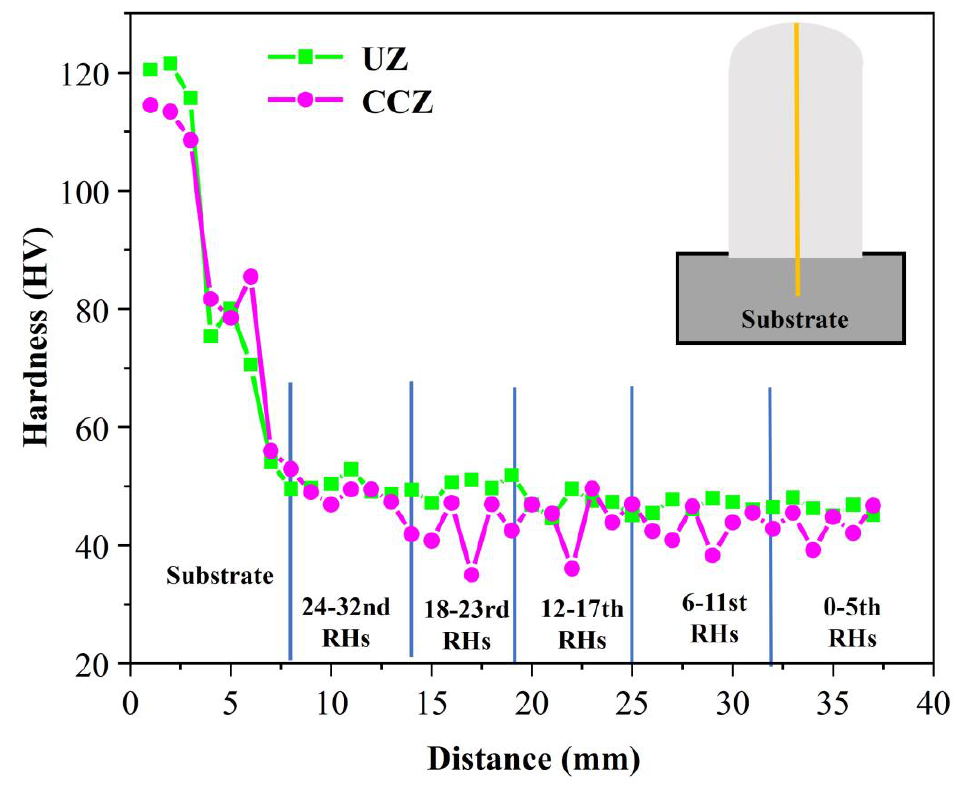
Figure 6. Microhardness distribution in different regions of a metallographic pattern.